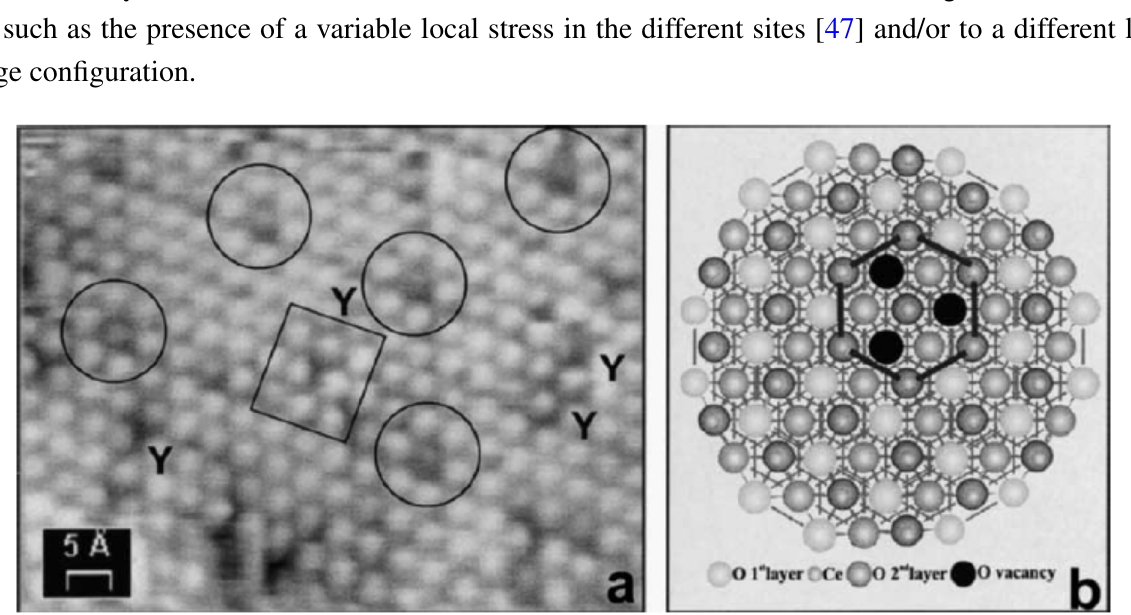
island on Rh(111), 2- x